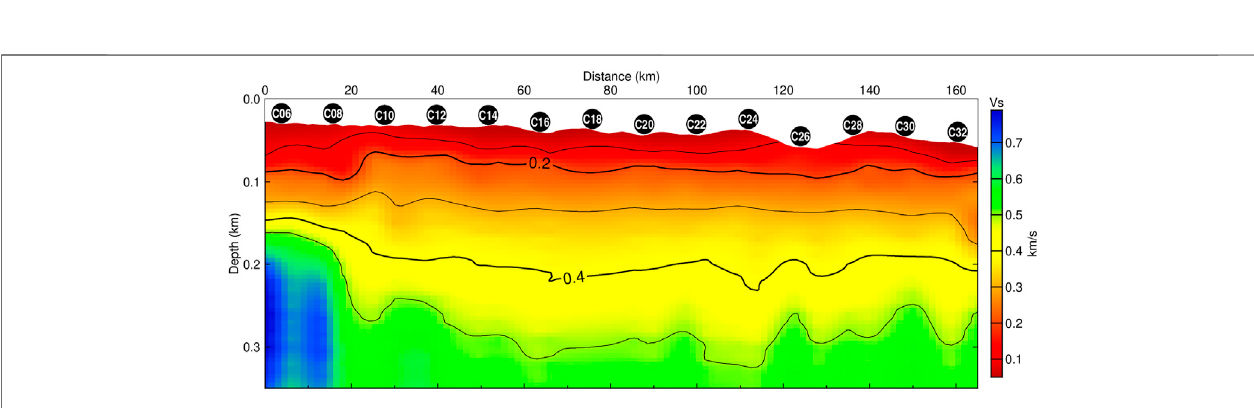
typical normal inverted structure (Wu et al., 2020).